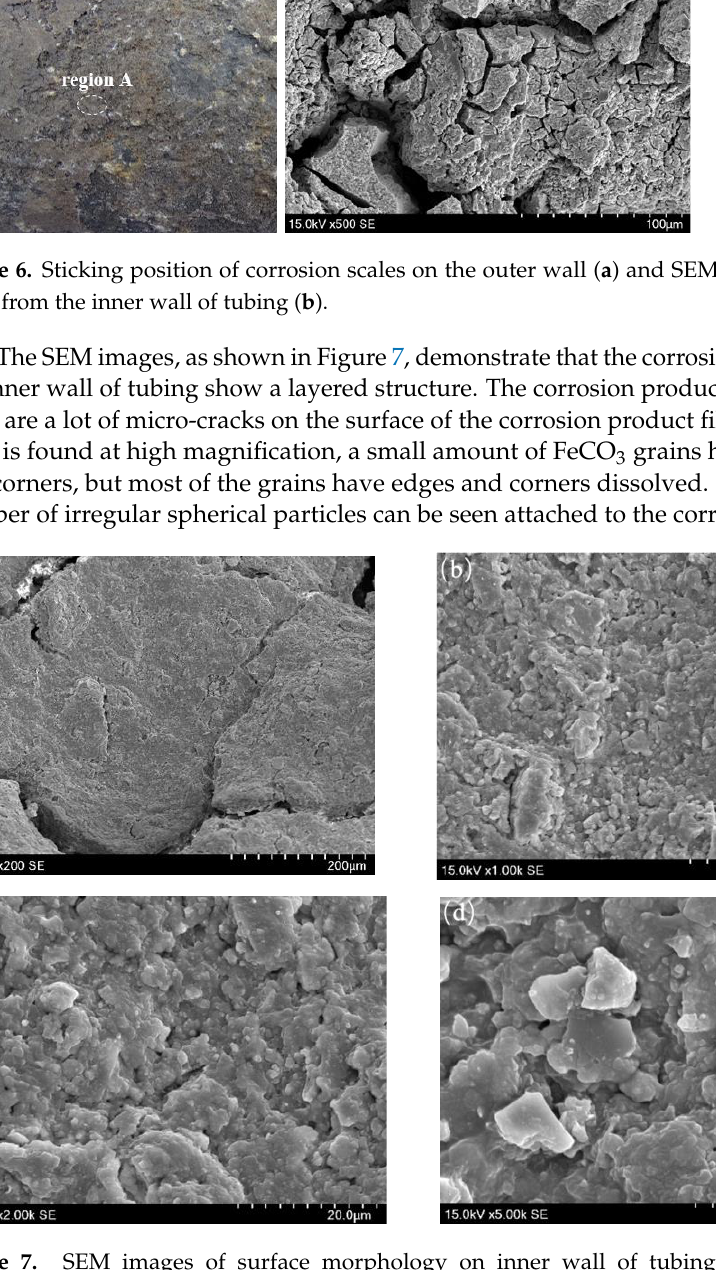
Figure 8. SEM images of surface morphology on outer wall of tubing. ( a ): 200 × SEM; ( b ): 1000 × SEM; ( c ): 2000 × SEM; ( d ): 5000 × SEM. As it shows in Figure 9, the component of the corrosion scales on the inner wall of the tubing is more complex, while that on the outer wall of the tubing is less so. Moreover, the salt content in the corrosion scales that stuck from the inner wall is less, while the salt content is rich in inner wall, indicating that the salts are concentrated in the inner layer. The corrosion scales on outer wall consist of Ca, Fe, C, Cl, and O, implying that the CO 2